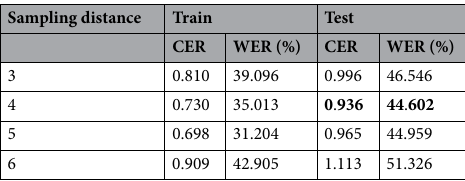
Table 3. Sampling distance tuning experiment result. Significant values are in [bold].